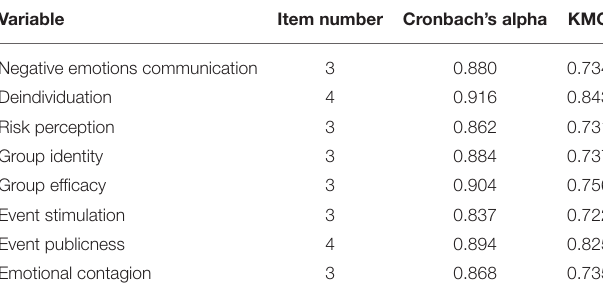
TABLE 3 | Reliability and validity analysis for each variable.